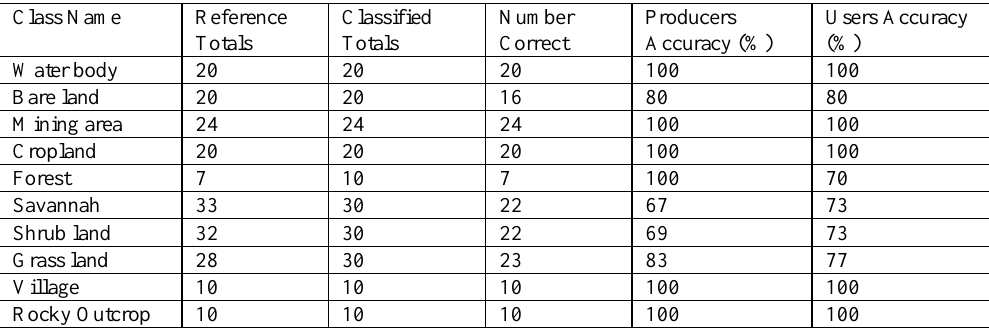
Overall Classification Accuracy=178/202=